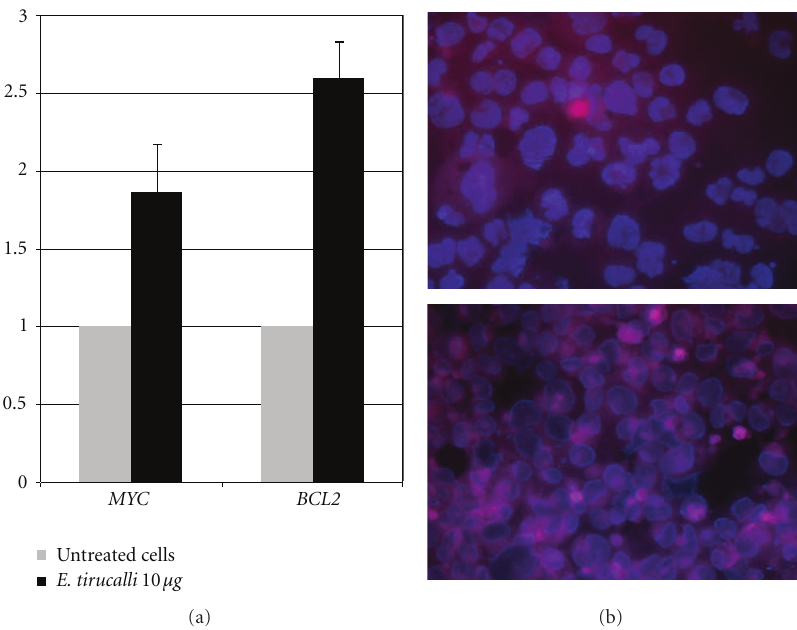
Figure 6: (a) qRT-PCR for BCL2 and MYC in untreated and E. tirucalli -treated cells. A marked up-regulation of both genes is observed following treatment. The graph is representative of three di ff erent qRT-PCR experiments. Error bars represent standard deviation between duplicates. (b) Immunofluorescence of untreated (upper panel) or E. tirucalli -treated cells (lower panel). c-MYC expression increases following treatment. Magnification 40x.